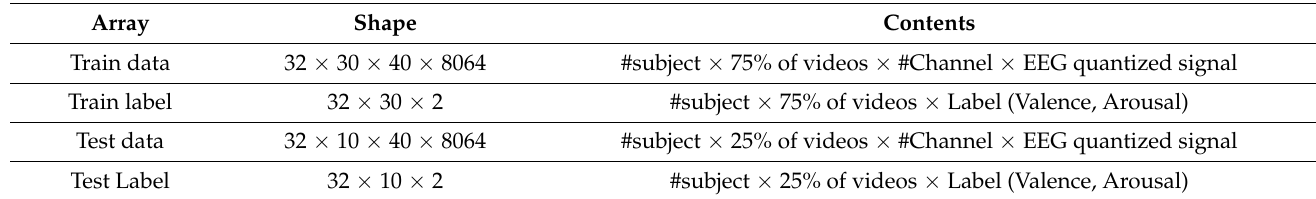
Table 4. Array size for train–test split of 75/25 ratio for raw EEG experiments.